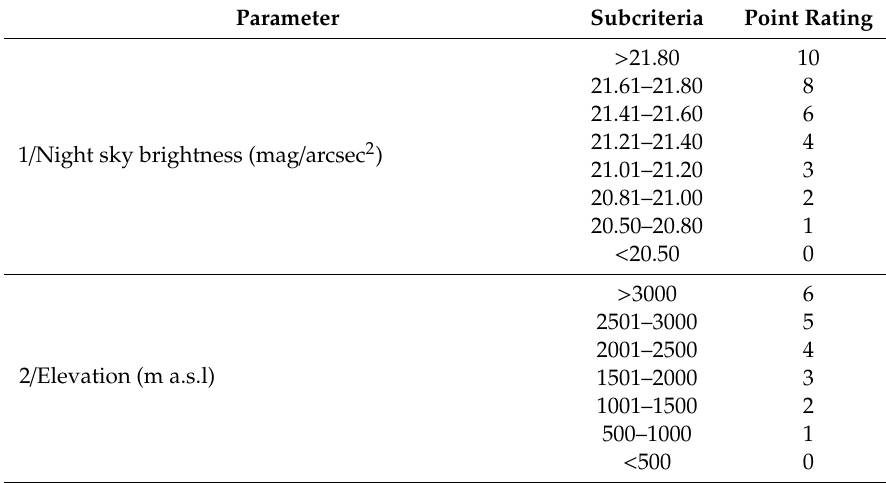
Table 2. Level of selected